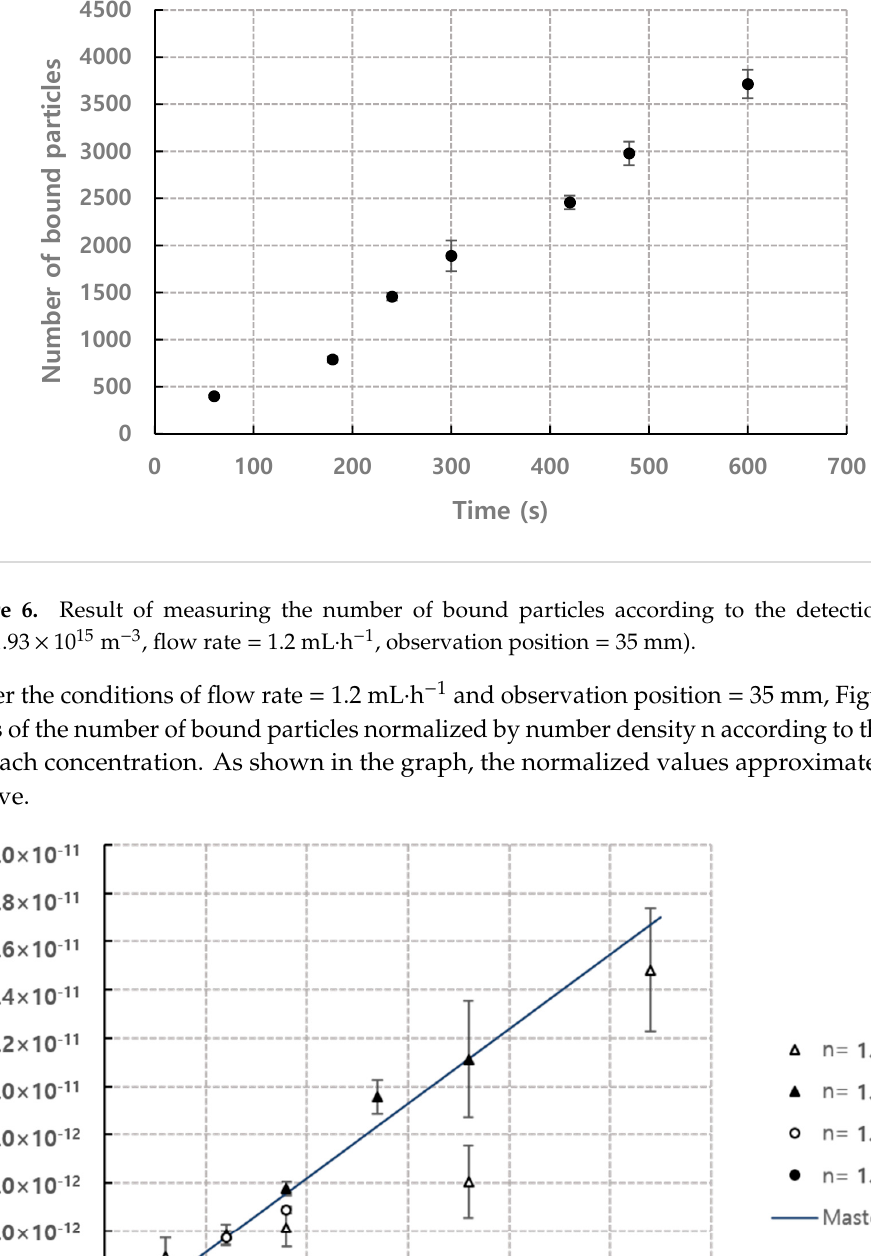
Figure 7. Normalized N bound according to the time for each concentration (Normalized by number density n), flow rate = 1.2 mL ·h − 1 , observation position = 35 mm. Master curve was fitted using the least square method ( (cid:1844) (cid:2870) = 0.90 ).